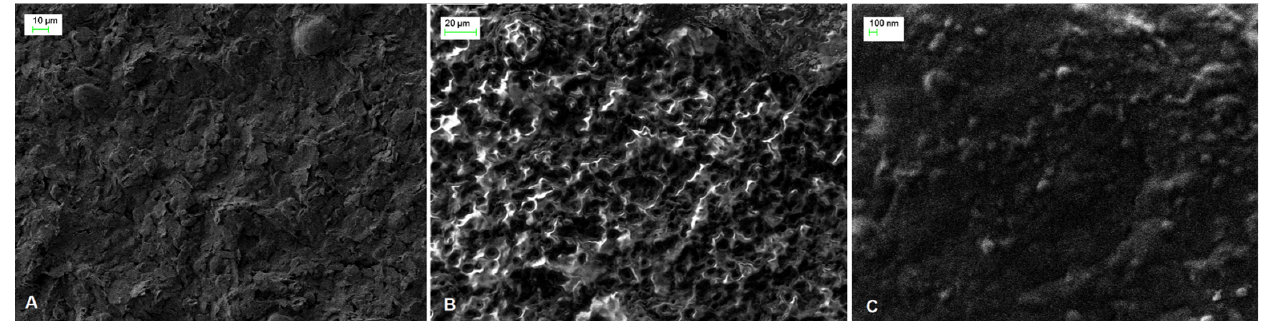
Figure 1. SEM images of ( A ) SPE, ( B ) PAH/SPE and ( C ) ADH-sol-gel/PAH/SPE sensors.